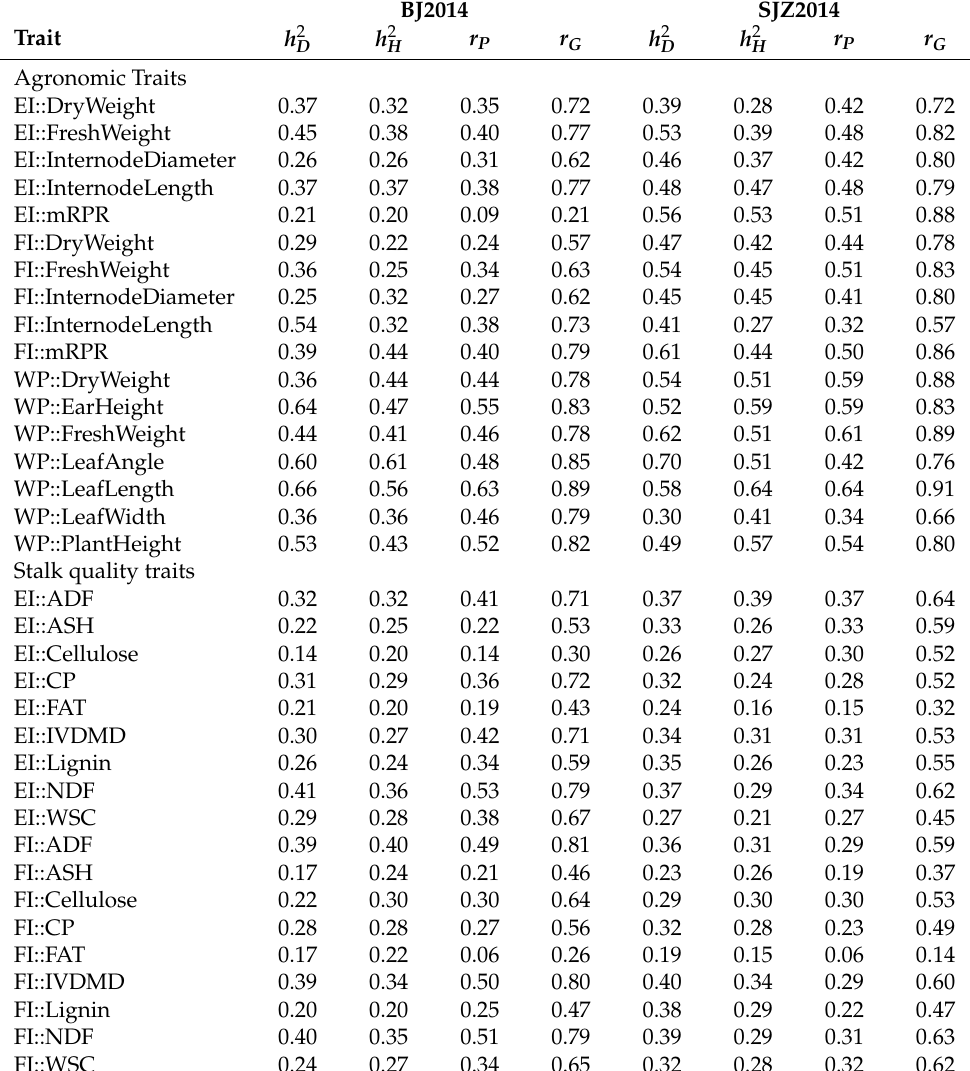
Table 1. Phenotypic ( r P ) and genotypic ( r G ) correlations between DH and corresponding haploid populations for the 35 traits evaluated from the internode under the primary ear (EI), the fourth internode above the ground (FI), and the whole plant (WP) in BJ2014 and SJZ2014. h 2 represent narrow-sense heritability of DH and haploid populations,